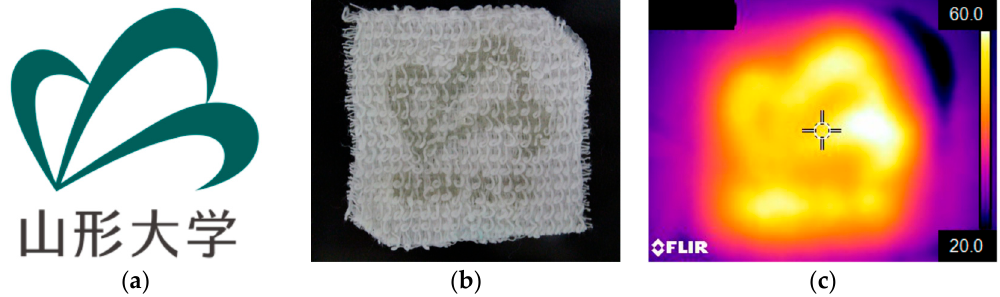
Figure 10. The logo of Yamagata University ( a ), the printed logo on cotton fabric using P(SA-DMAA) gel (3DP 0.25) as printing material on LumiForge ( b ), and its infrared thermal picture supplied by an infrared thermal graphic camera shown thermal energy storage capacity ( c ).